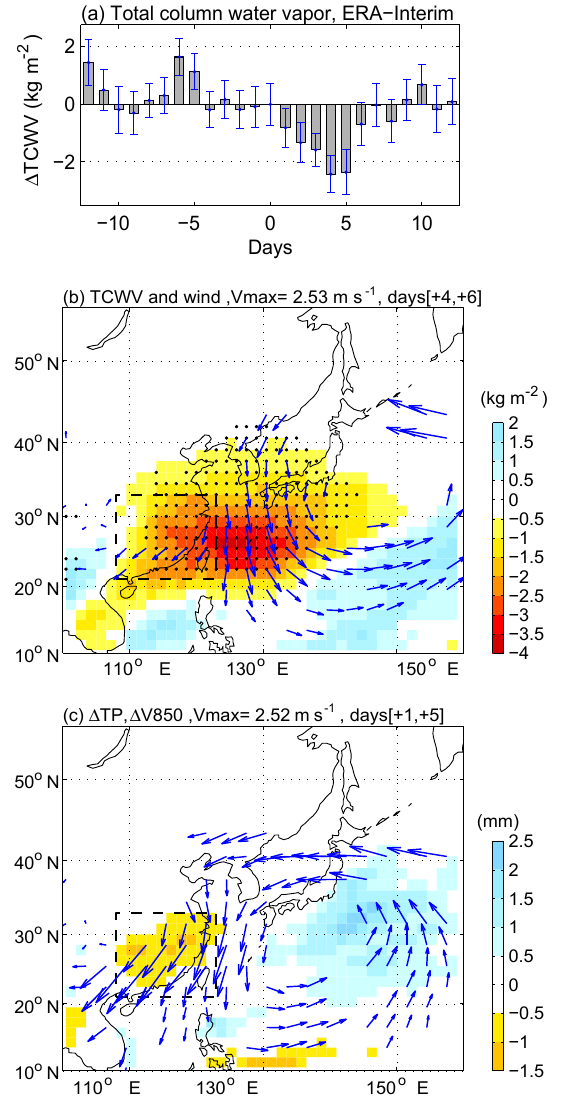
Figure 9. (a) Temporal anomalies of the total column water va- por ( (cid:49) TCWV) during the holiday. (b) Spatial distribution of the (cid:49) TCWV (in color shading with units of kgm − 2 ) and the 700– 1000hPa mean horizontal wind anomalies (in vectors with units of ms − 1 ) during days [ + 4, + 6]. Stipples denote significant (cid:49) TCWV (at the 0.05 level). Only the anomalous wind vectors significant at the 0.05 level are plotted. (c) Spatial distribution of the mean anomalies of the total precipitation ( (cid:49) TP; in color shading with units of mm) and the significant (at the 0.05 level) 850hPa mean horizontal wind anomalies (in vectors with units of ms − 1 ) during days [ + 1, +